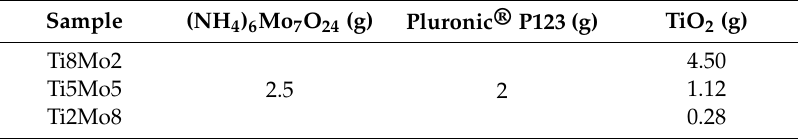
Table 1. Quantities of substrates used for synthesis of TiO 2 -MoO 3 composite